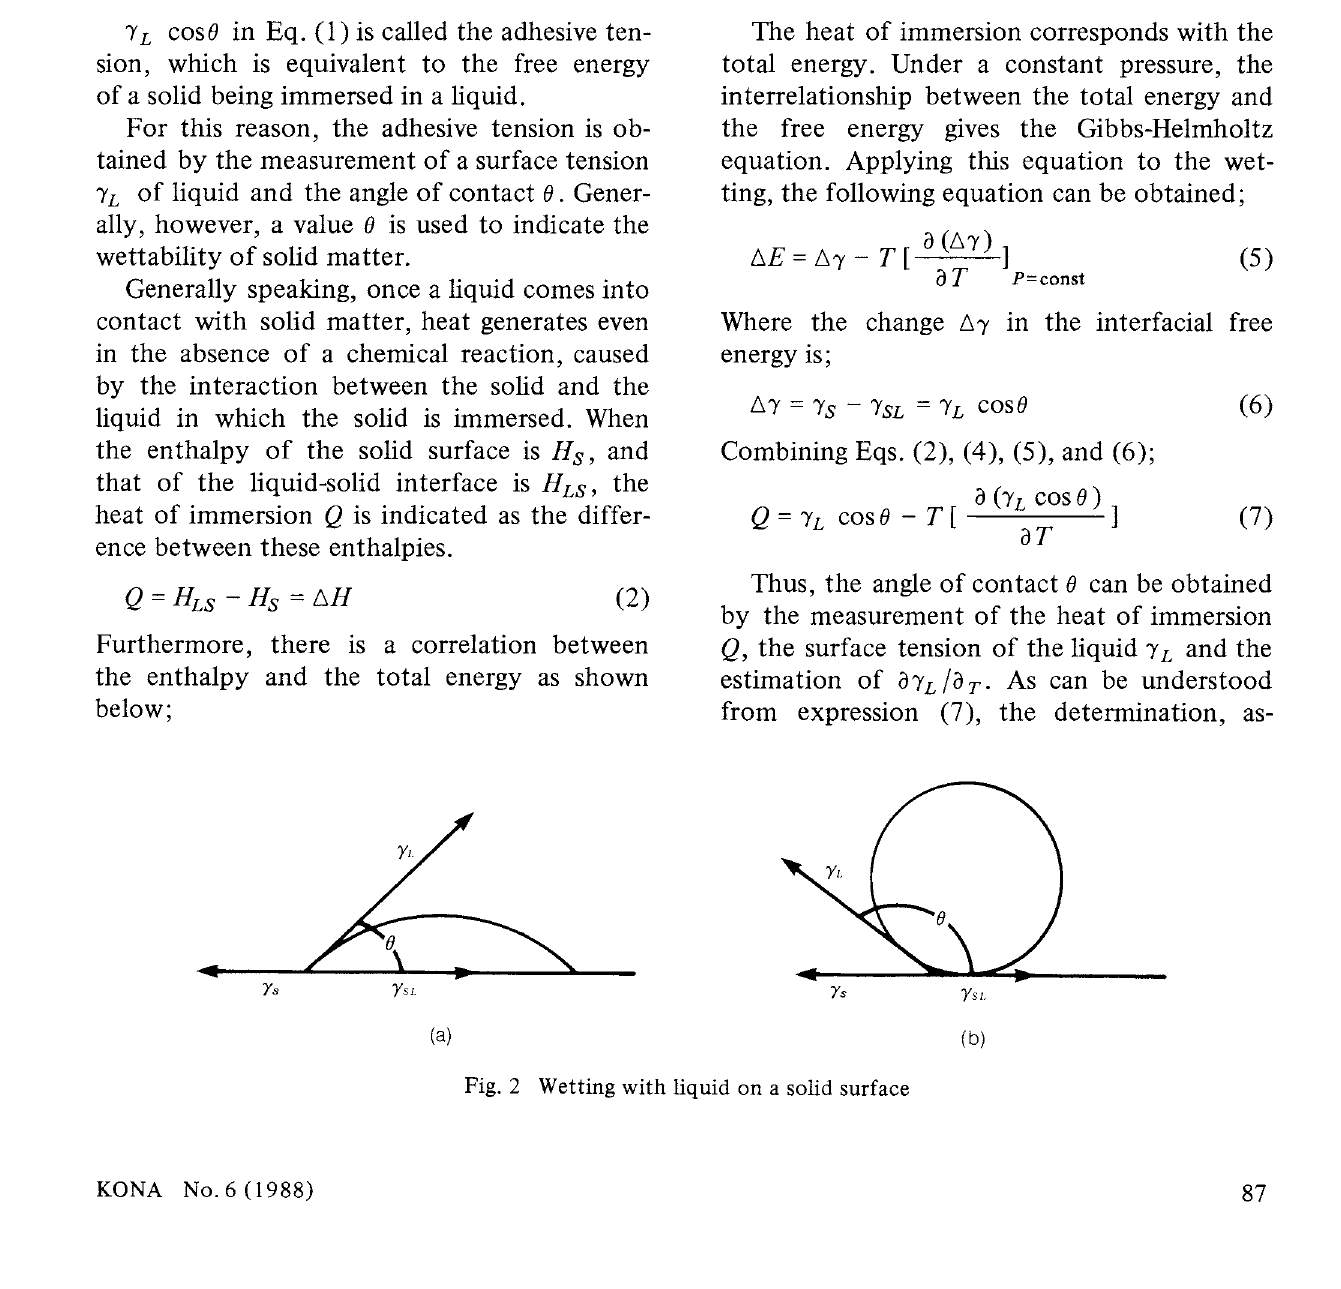
Fig. I Change in energy of the wetting process